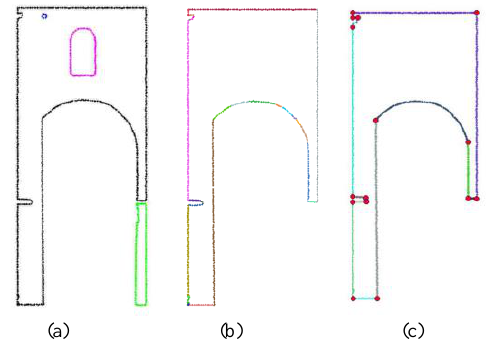
Figure 14. From contour points to vector contours; a) classification of points; b) detection of linear segments; c) intersection of linear segments